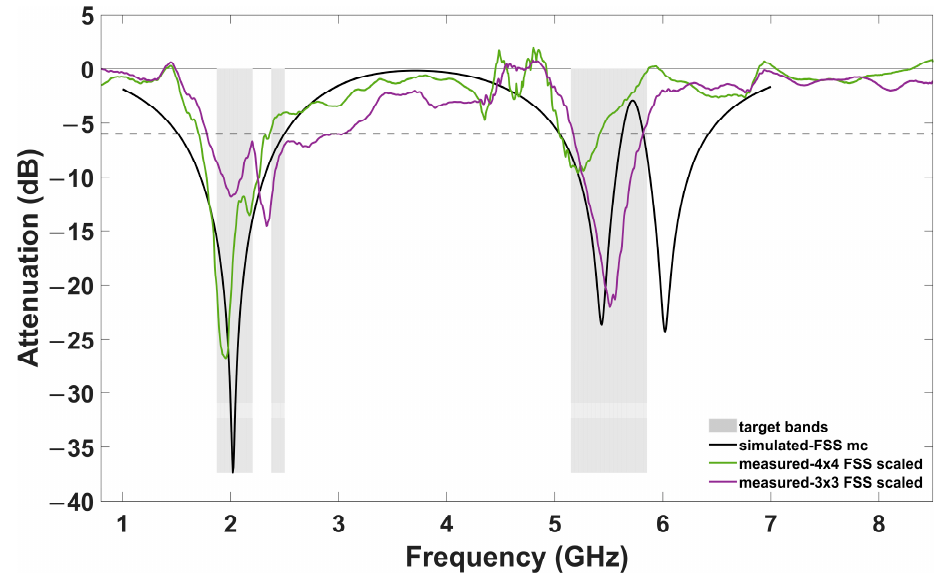
Figure 12. Comparison of simulated FSS mc (unit cell boundary condition) and measured FSS scaled .